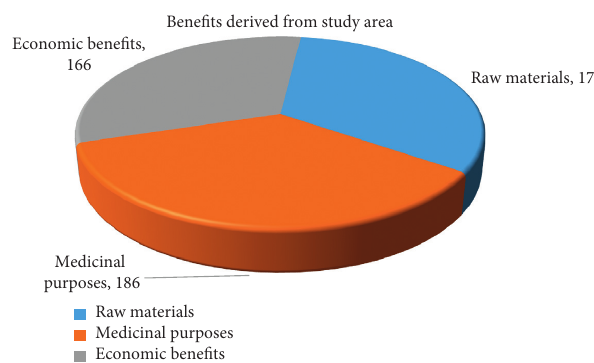
Figure 3: Pie chart depicting the benefits derived from study area (source: Fieldwork